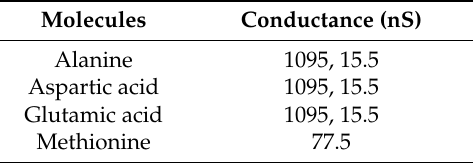
Figure 4. Typical conductance ( a ) curves and ( b ) histogram of methionine (from 1150 curves) contacting with Au electrode. Table 1. Summary of single molecular conductance of alanine, aspartic acid, glutamic acid, and